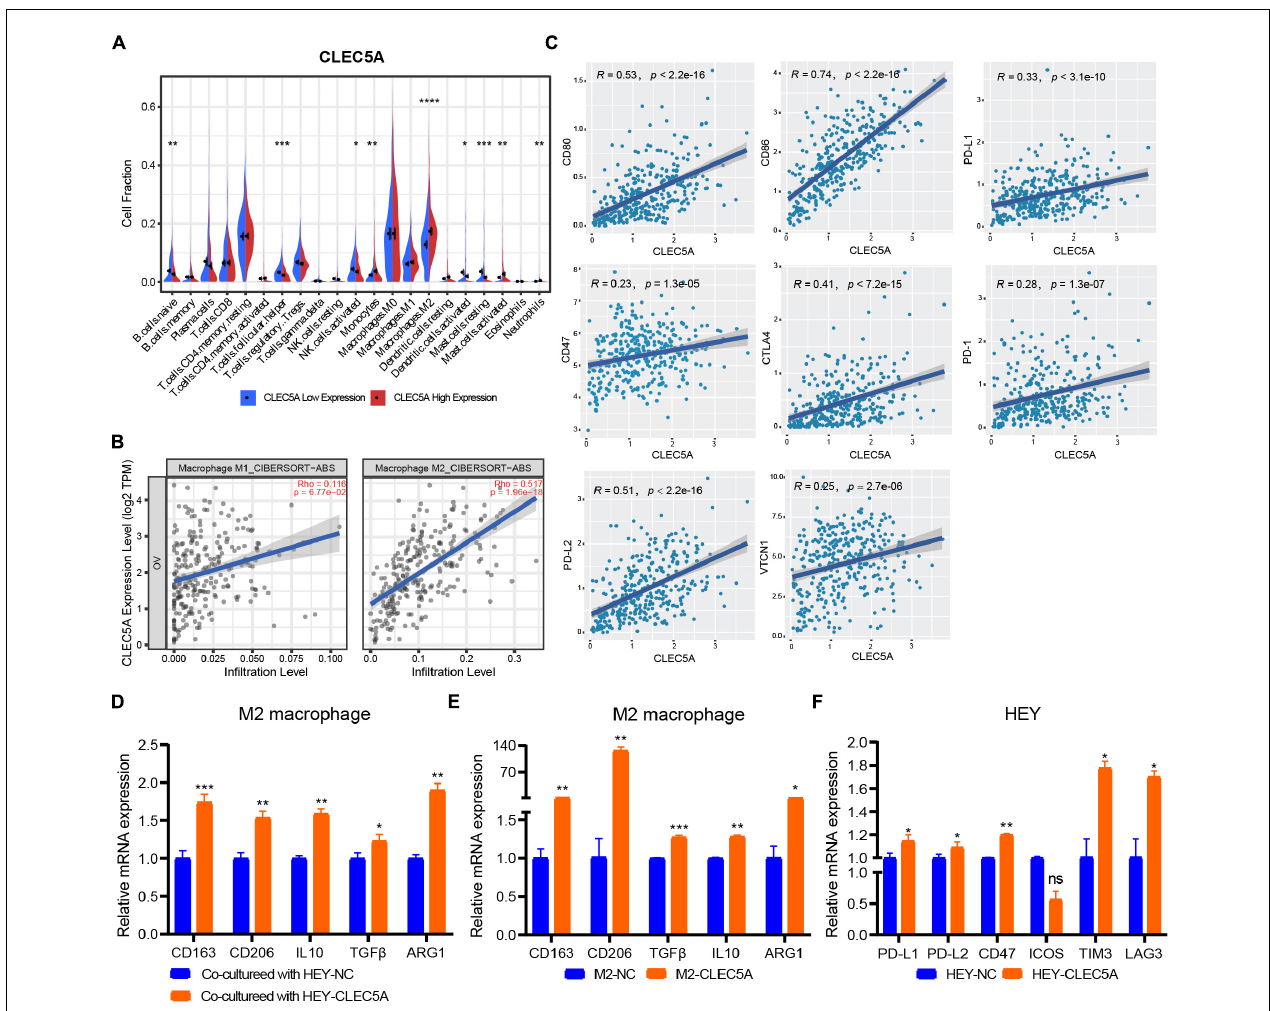
FIGURE 6 | (A) Correlation analysis of CLEC5A expression and immune cell components in the TME of OC (TCGA-OV dataset). (B) Correlation analysis between the expression of CLEC5A and the infiltration of M1 and M2 macrophages in TME of OC. (C) Correlation analysis of CLEC5A expression and immune checkpoint gene. (D) When the M2 macrophages were co-culture with OC cell line HEY overexpressing CLEC5A, the M2 polarization level of macrophages increased. (E) After overexpression of CLEC5A in M2 macrophages, the M2 polarization level increased. (F) The expression of immune checkpoint genes PD-L1, PD-L1, CD47, TIM3, and LAG3 increased in OC cell line HEY overexpressing CLEC5A. **** p < 0.0001; *** p < 0.001; ** p < 0.01; * p < 0.05; ns, no